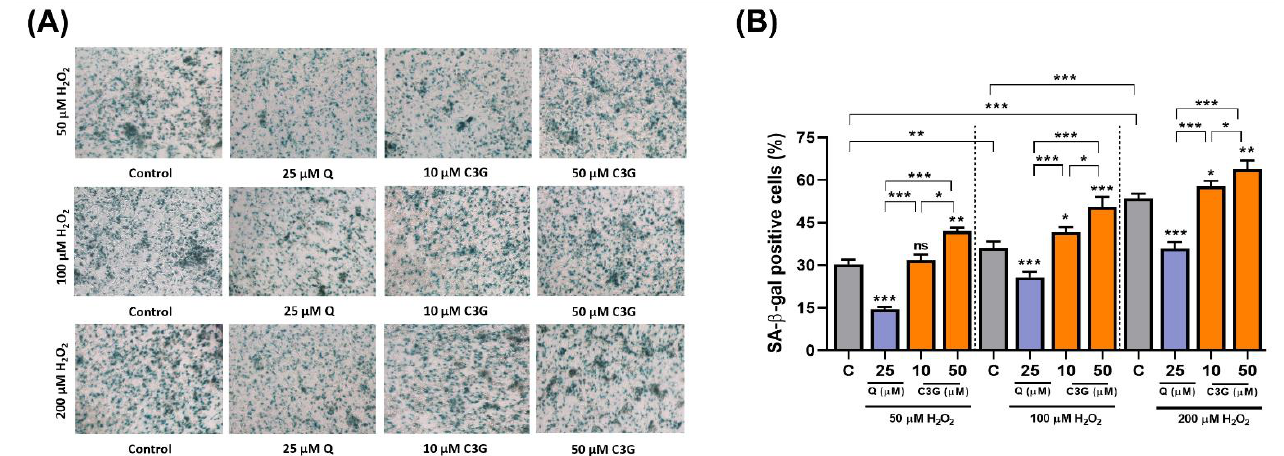
Figure 5. Effect of C3G on anti-cancer activity by inducing senescence in hepatocarcinoma cells. ( A ) SA- β -Gal activity in HepG2 cells treated with 50, 100 and 200 µ M H 2 O 2 . Micrographs were obtained with phase contrast microscopy. ( B ) Quantification of SA- β -Gal+ cells cultures shown in ( A ). SA- β -Gal+ cells were scored in 3 fields of at least 450 total cells. The results represent the mean ± SEM (n = 3). For comparisons between two groups, Student’s t -test was performed. *, p < 0.05; **, p < 0.01; ***, p < 0.005 compared with controls. C, control (0.1% DMSO); C3G, Cyanidin 3-glucoside; Q. Quercetin; ns, not statistically